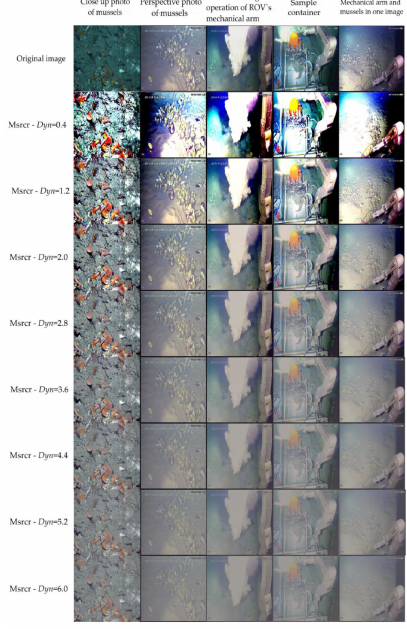
Figure 4. Enhancement of MSRCR under different parameters. Table 1. MSRCR and CycleGAN image enhancement statistical data of UIQM values for Qiongdong- nan and North Sea cold